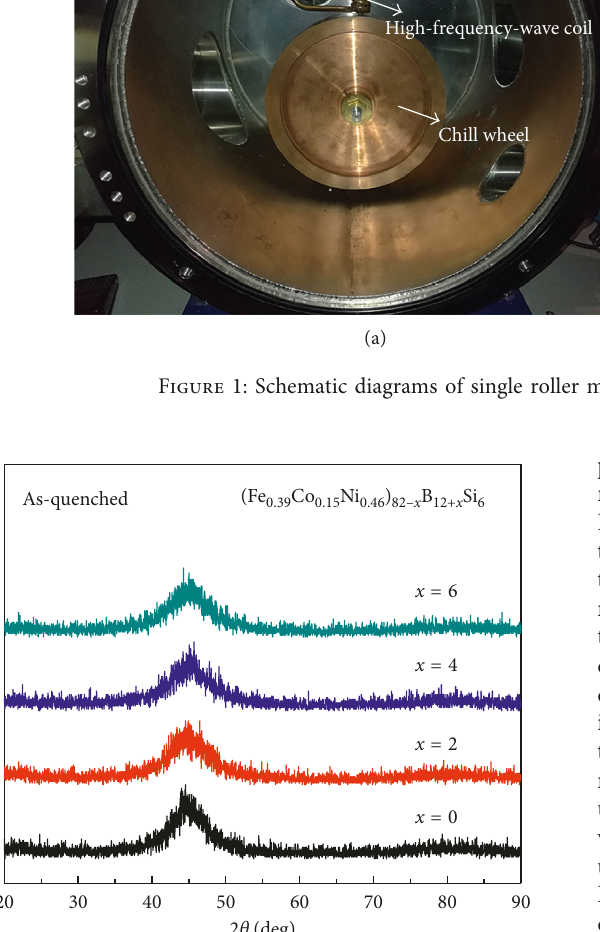
0.39 Co 0.15 Ni 0.46 ) 82